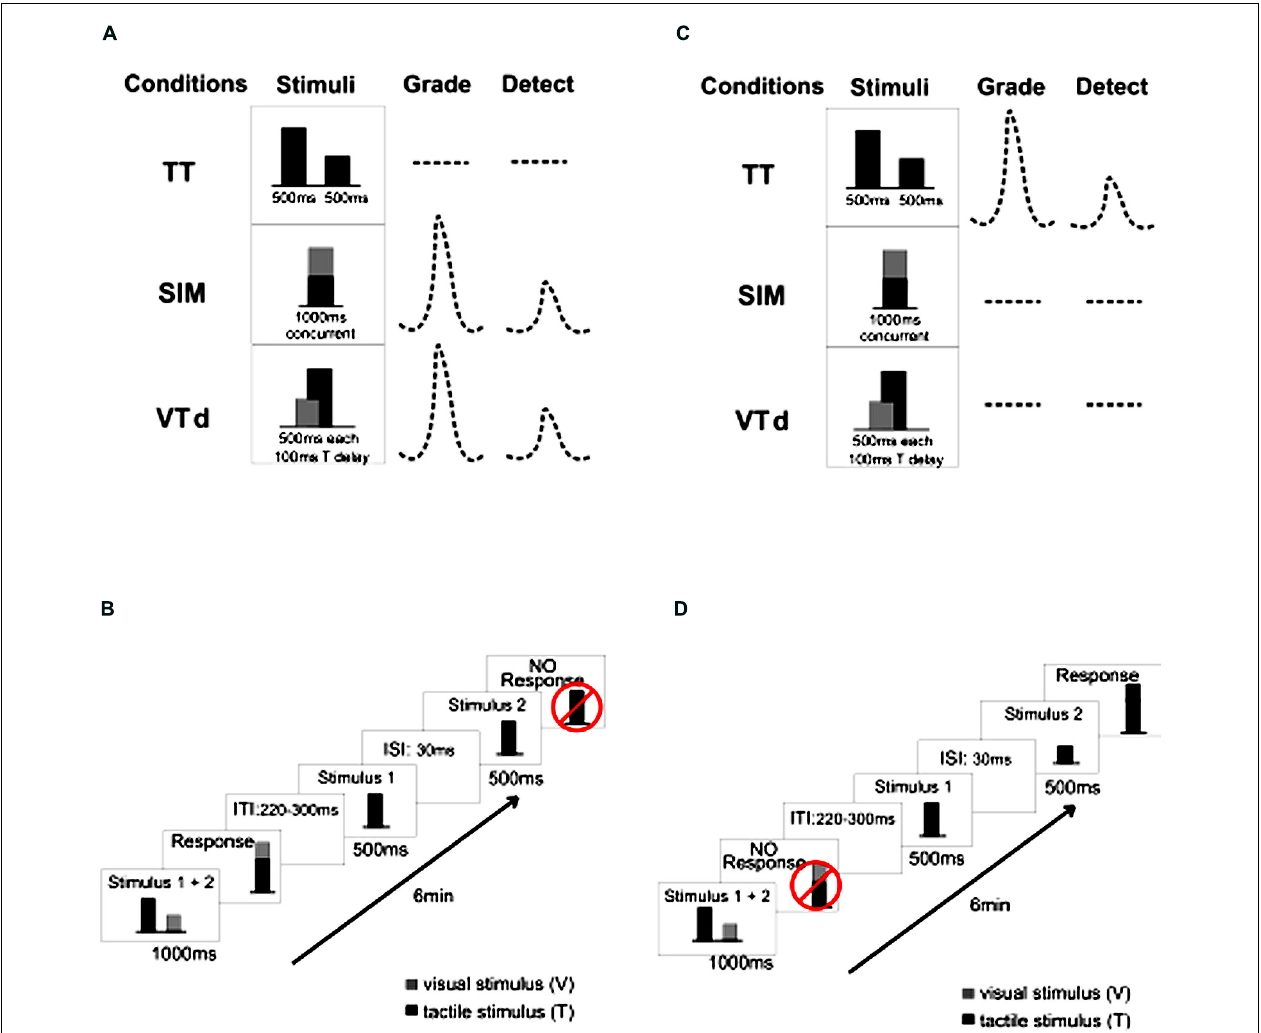
VT pairs (SIM). Participants performed three motor tasks where the integrated the amplitudes between the two stimuli (Grade), indicated the presence of the attended stimulus type (Detect) or judged which of the two in the stimulus pair would require a larger response (Judge – similar response to Detect; see text for details). In Experiment 2 there were also stimulus pairs where the onset of the visual stimulus preceded the tactile stimulus by 100 ms. Each block of trials lasted approximately 6